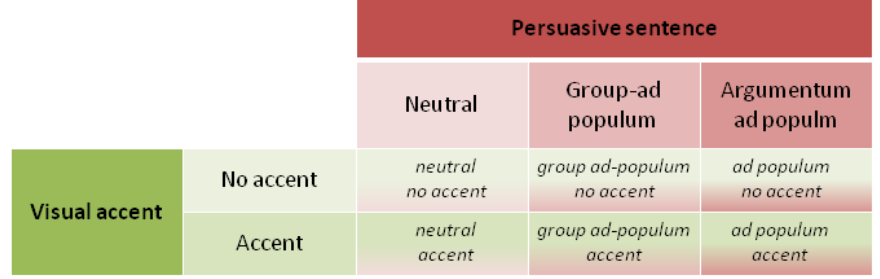
Figure 3. Experimental